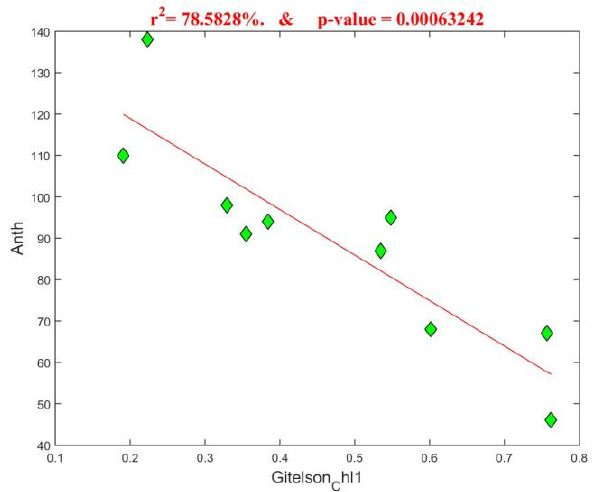
Figure 6. The highest correlation rate for the estimation of Anthocyanin levels for the 2015 dataset in Amynteo was established with the Gitelson_Chl2 and Gitelson_Chl1